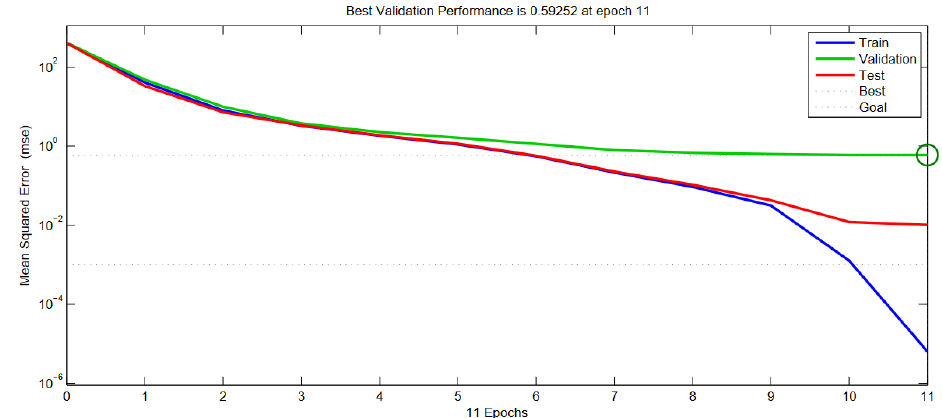
Figure 32. Evaluation of mean squared error (for the quasi-periodic array example).